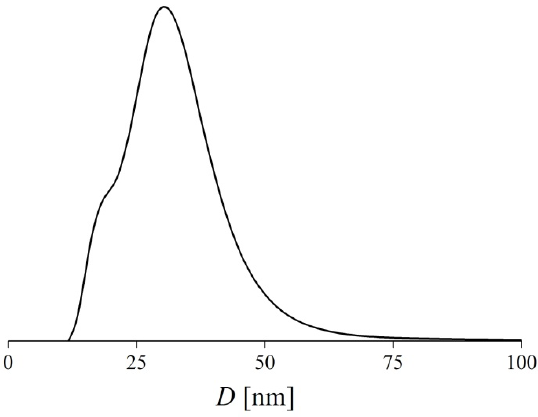
Figure 1. Nanoparticles size distribution in hydrosol according to quasielastic light